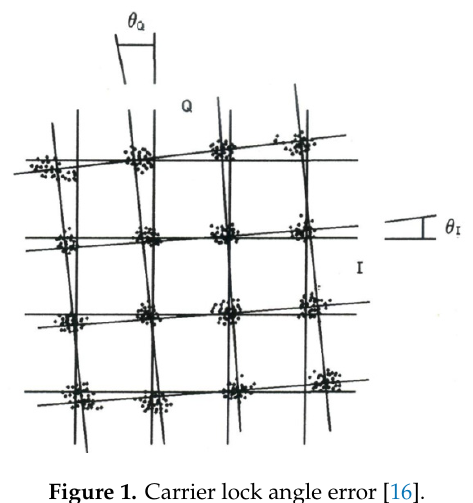
Figure 1. Carrier lock angle error [16].